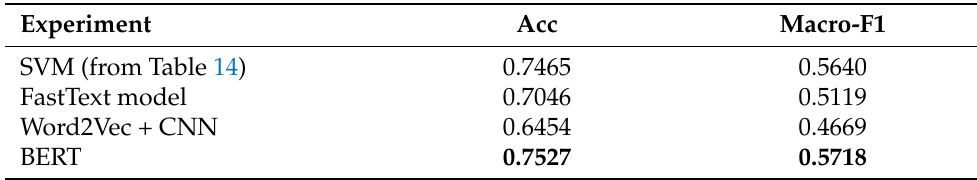
Table 22. Results obtained using word